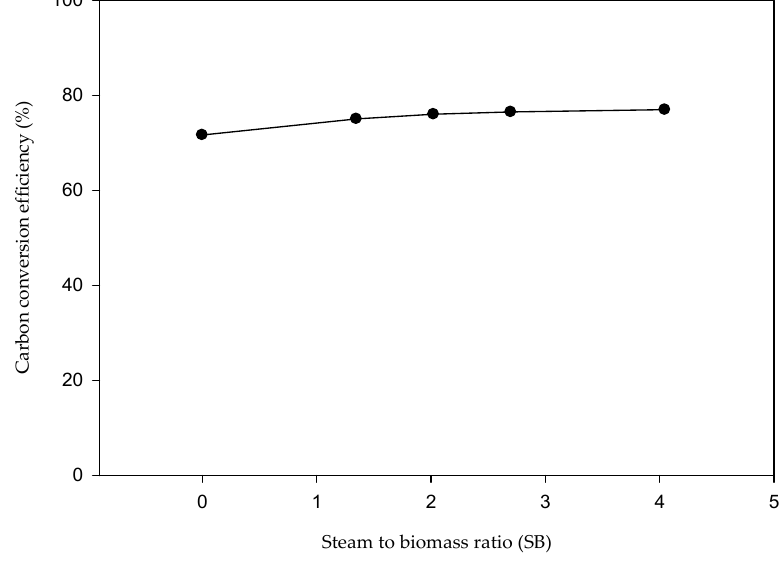
Figure 8. Carbon conversion efficiency with respect to steam to biomass ratio.